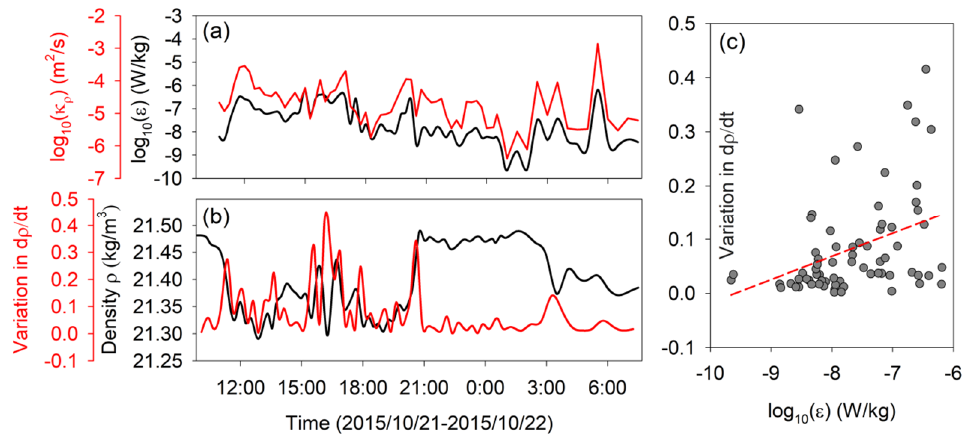
Figure 12. Time courses of the ( a ) average dissipation rate and diffusivity, and ( b ) average density and variation in dρ/dt. ( c ) Relationship between the dissipation rate and variation in dρ/dt.